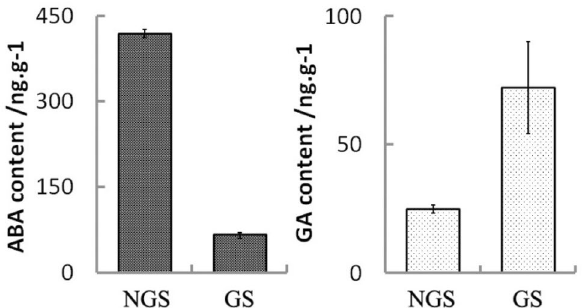
Figure 2. Measurement of ABA and GA 3 levels in non-germinated and germinated seeds. NGS non-germinated seeds; GS germinated